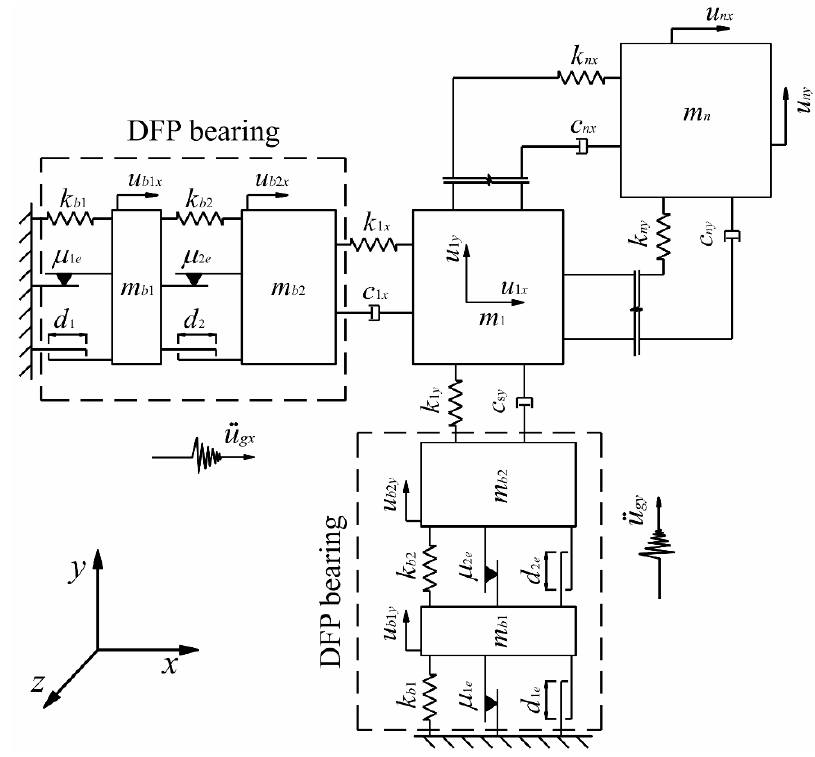
Figure 2. Series model of the DFP bearing and multi-degree of freedom model of the superstruc-